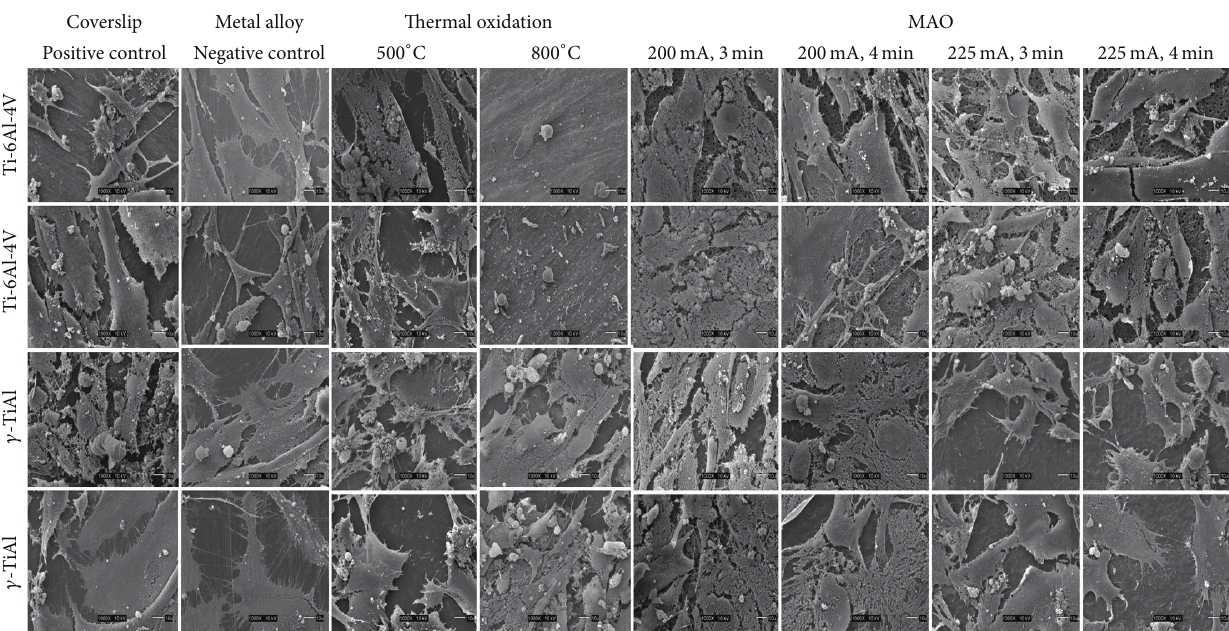
Figure 2: SEM micrographs of hFOB 1.19 cells on a glass coverslip (positive control), GTi and TiV (untreated alloys), thermally oxidized TiV5 and GTi5 (500 ∘ C), TiV8 and GTi8 (800 ∘ C), micro arc oxidized (MAO) TiV (200 mA and 225 mA at 3 min and 4min), and MAOGTi (200 mA and 225 mA at 3min and 4 min) disks. Magnification